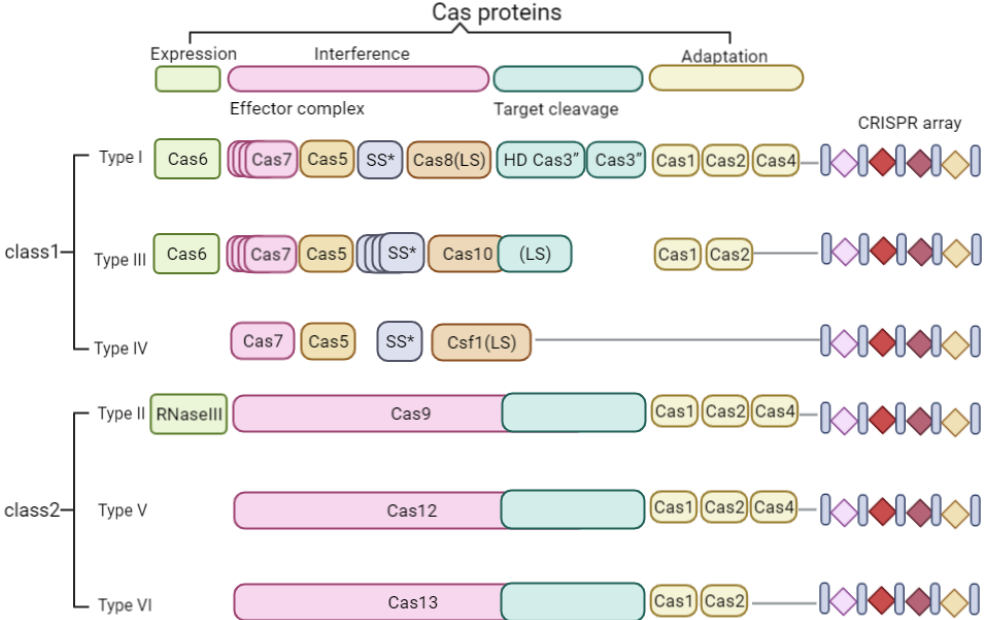
Figure 1. Characteristics of different types of CRISPR/Cas systems. CRISPR/Cas systems are classified as types I to VI. Type I systems are characterized based on the occurrence of signature protein Cas3, a protein which contains both DNase and helicase domains used to degrade the target. Type II CRISPR/Cas systems use Cas1, Cas2, Cas9, and a fourth protein (Csn2 or Cas4), whereas the type III CRISPR/Cas systems comprise the Cas10 with an indistinct role. The type II CRISPR/Cas system originates from S. pyogenes and comprises three components: the CRISPR RNA (crRNA), trans-activating crRNA (tracrRNA), and a Cas9 protein. The type V CRISPR/Cas system (Cas12) is an RNA-guided system which is analogous to CRISPR/Cas9 but exhibits some unique characteristics. This CRISPR system relies on a T-rich sequence at the 5 ′ -end of the protospacer sequence (5 ′ -TTTN-3 ′ or 5 ′ -TTTV-3 ′ ; V = A, C, or G, in some cases), as opposed to the G-rich, NGG sequence for Cas9. The type VI system (Cas13) is effector protein for RNA cutting, which is used as RNA-guided ribo- nuclease, the nonspecific, trans-acting RNase activity of which is activated by base pairing of the crRNA guide to an ssRNA target. The Cas7, Cas5.SS*, Cas8(LS), Cas10 and CSf1(LS) have been drew with different colors, but they all belong to interference part of class I.